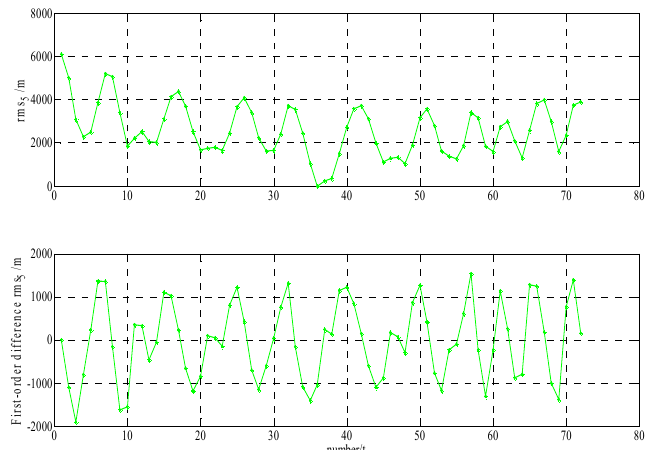
( ) rms t and ( ) rms t and 4 4 ( ) rms t and 4